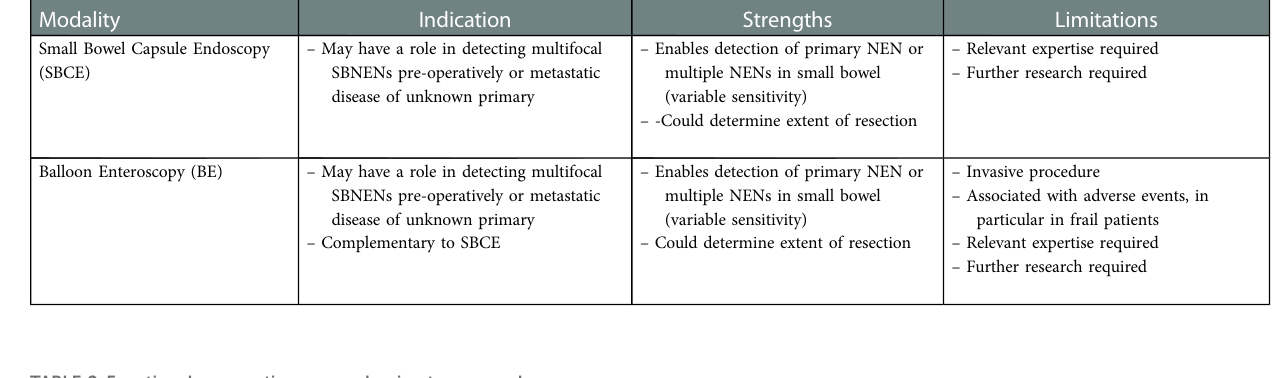
TABLE 2 Functional pancreatic neuroendocrine tumor